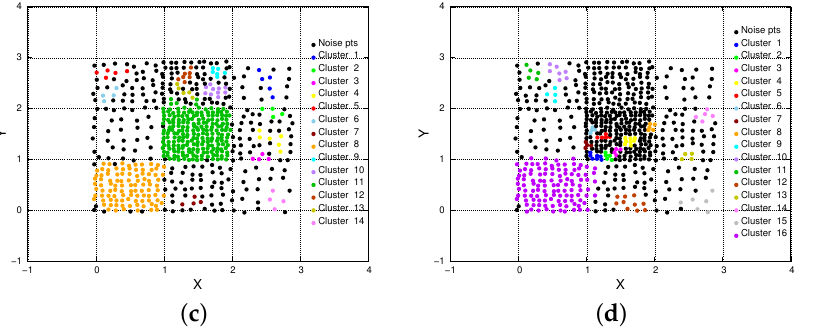
Figure 8. The Chess dataset: detected clusters. ( a ) CHD. ( b ) DBSCAN. ( c ) HDBSCAN. ( d ) OPTICS-Xi.